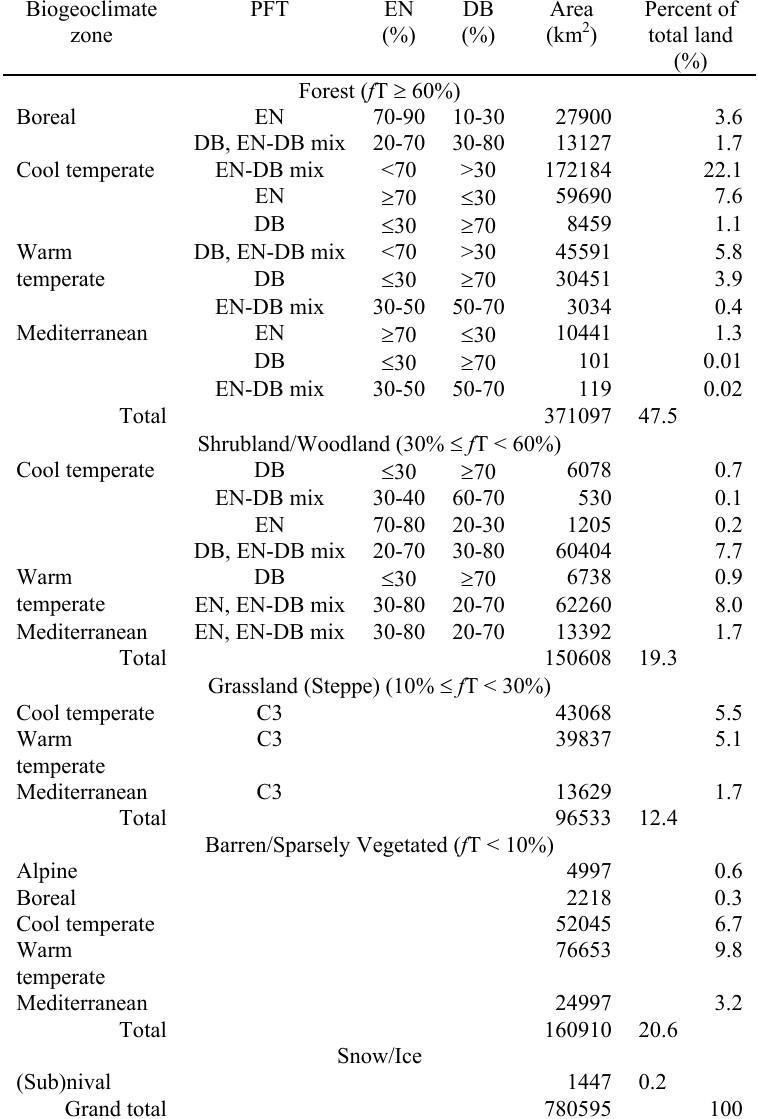
Table 3. Biogeoclimatic distribution of plant functional type (PFT) mixtures according to the IGBP land-cover